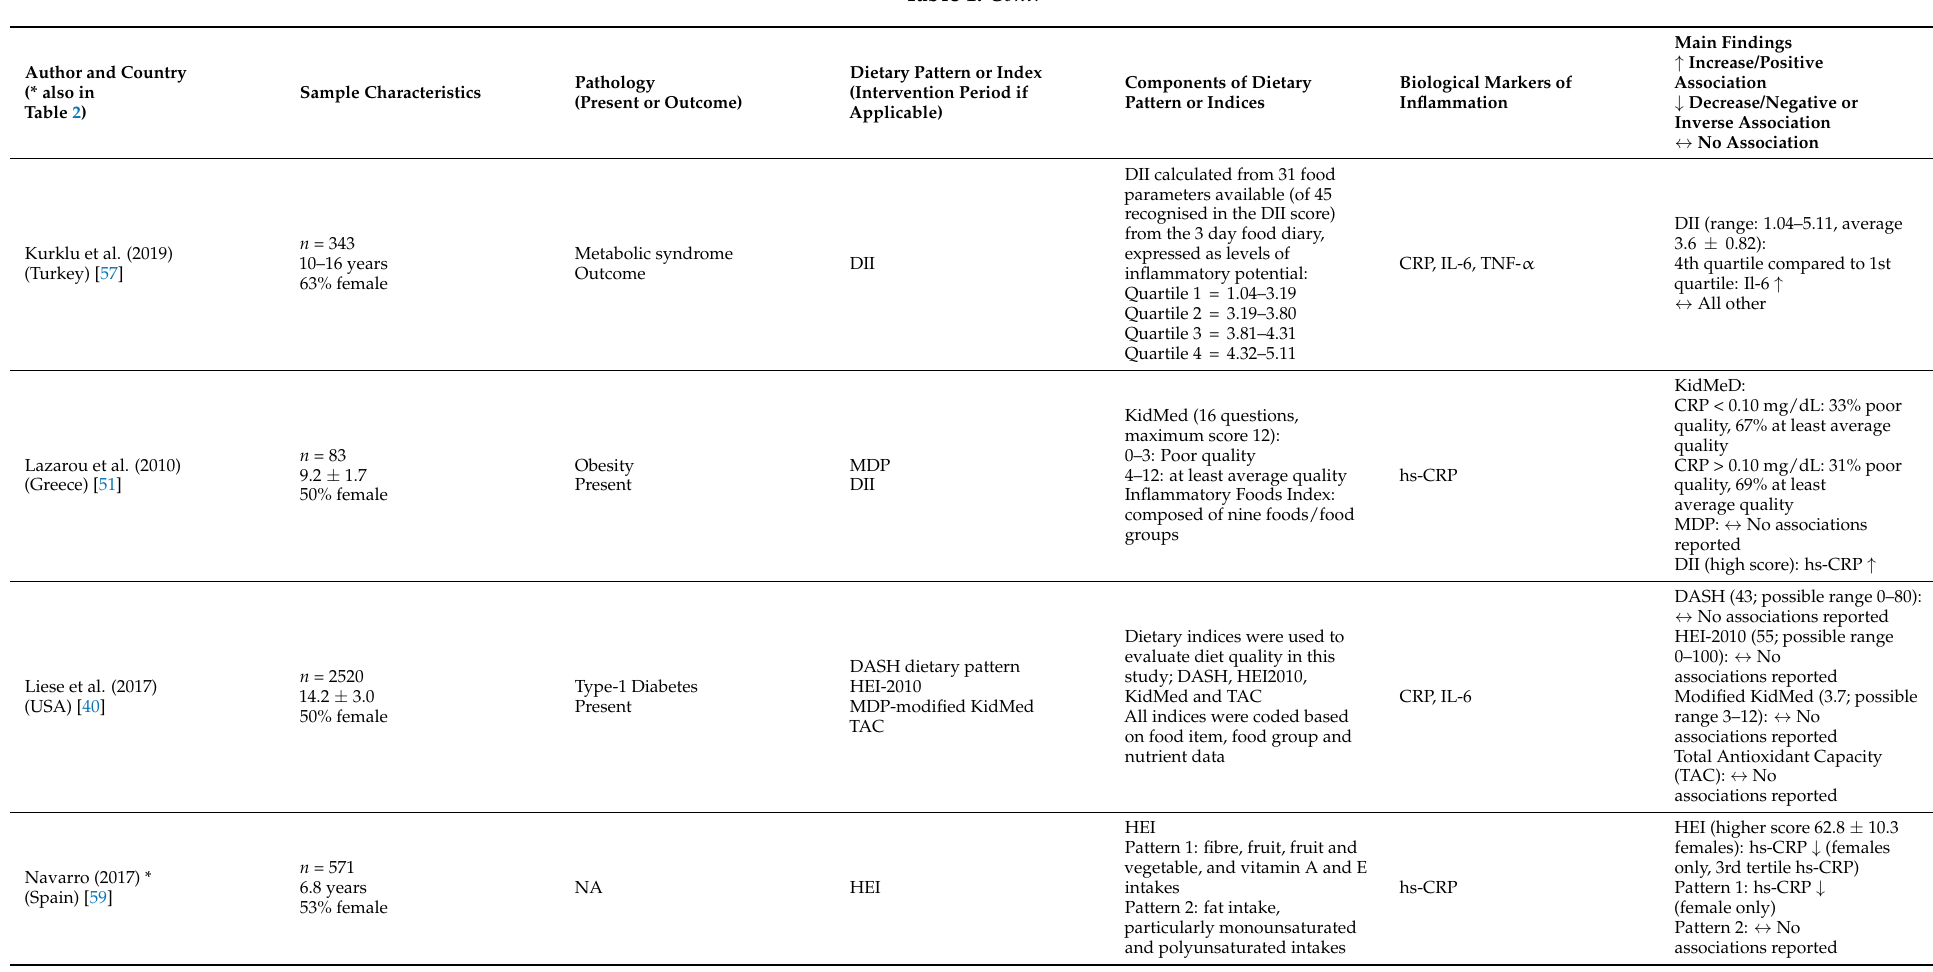
HEI Pattern 1: fibre, fruit, fruit and vegetable, and vitamin A and E intakes Pattern 2: fat intake, particularly